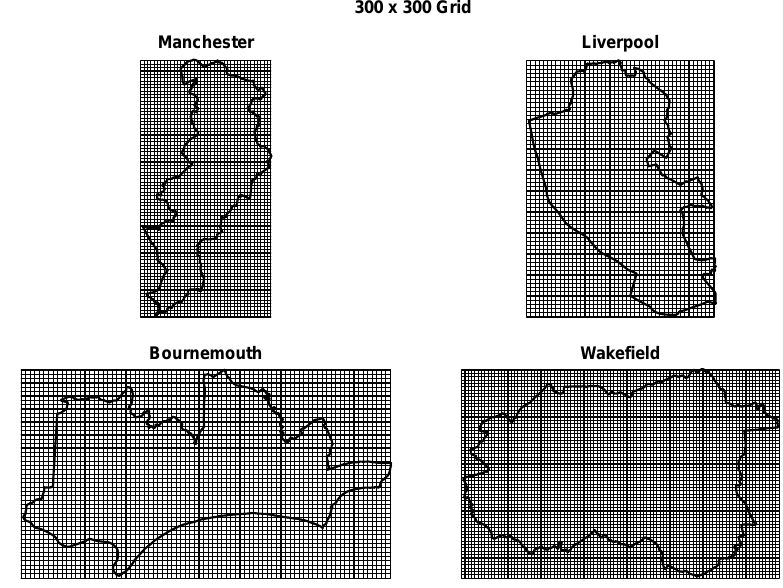
Figure 5. The 300 × 300-meter grid for geographical